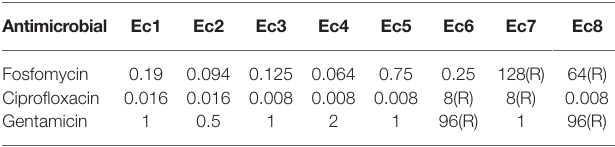
TABLE 3 | MIC of E. coli by Etest. Antimicrobial Ec1